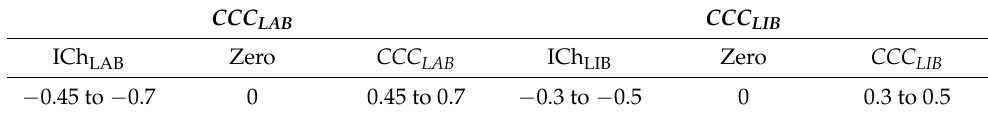
Table 4. The output membership functions for CCC LAB and CCC LIB variables for cases one and two.